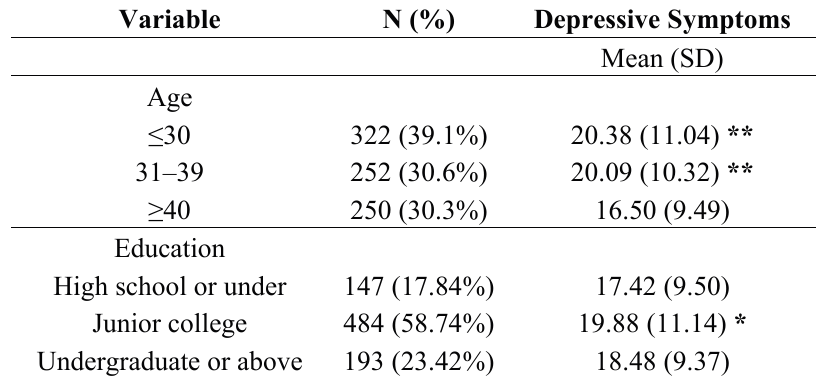
Table 2. Demographic characteristic of subjects and the distributions of depressive